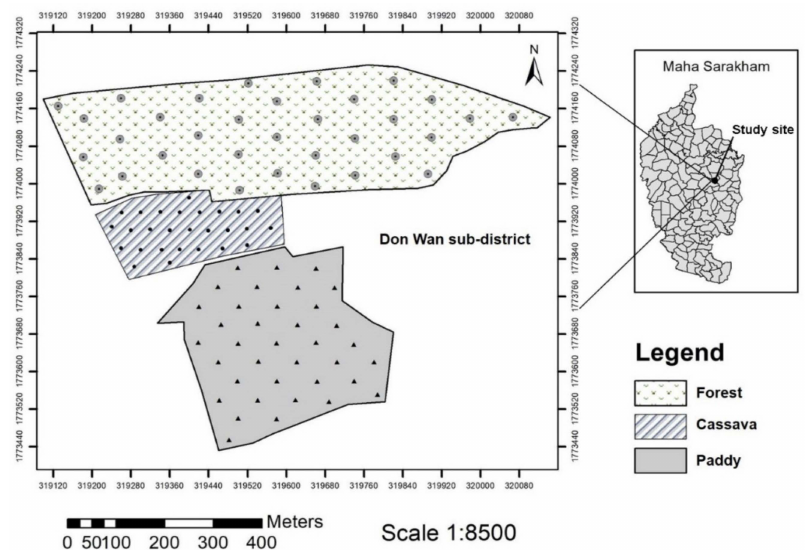
Figure 1. Location of soil sampling sites in Maha Sarakham province in Northeast Thailand.